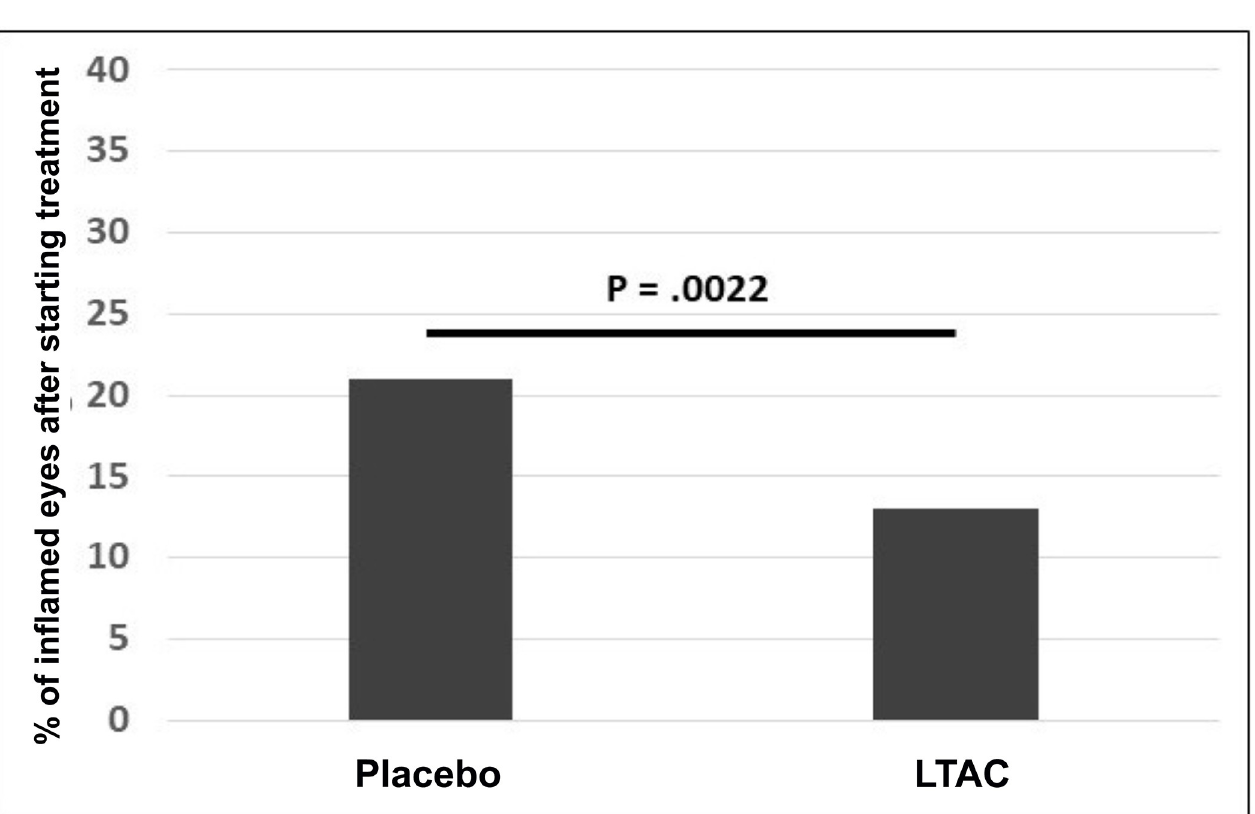
Fig 6. Treatment responses to LTAC nanoparticle eye drops in cats with experimentally-induced recurrent FHV-1 surface ocular infection. Purpose-bred cats previously infected with FHV-1 (at least 6 months prior) were re-inoculated by corneal instillation of FHV-1, to induce ocular infection and clinical signs. Cats were randomly assigned to an LTAC treatment group (n = 8) and a control group treated with tear replacement (n = 9) as a placebo. Both eyes were treated the first day inflammation was noted in either eye and continued for 10 days. Cats with no ocular inflammation by Day 5 were treated with the respective product for 10 days. Figure shows the proportions of inflamed eyes over the 10-day treatment period compared by Fisher’s exact test and cats treated with LTAC nanoparticles experienced significantly lower days with inflammation than control cats (p = 0.002).